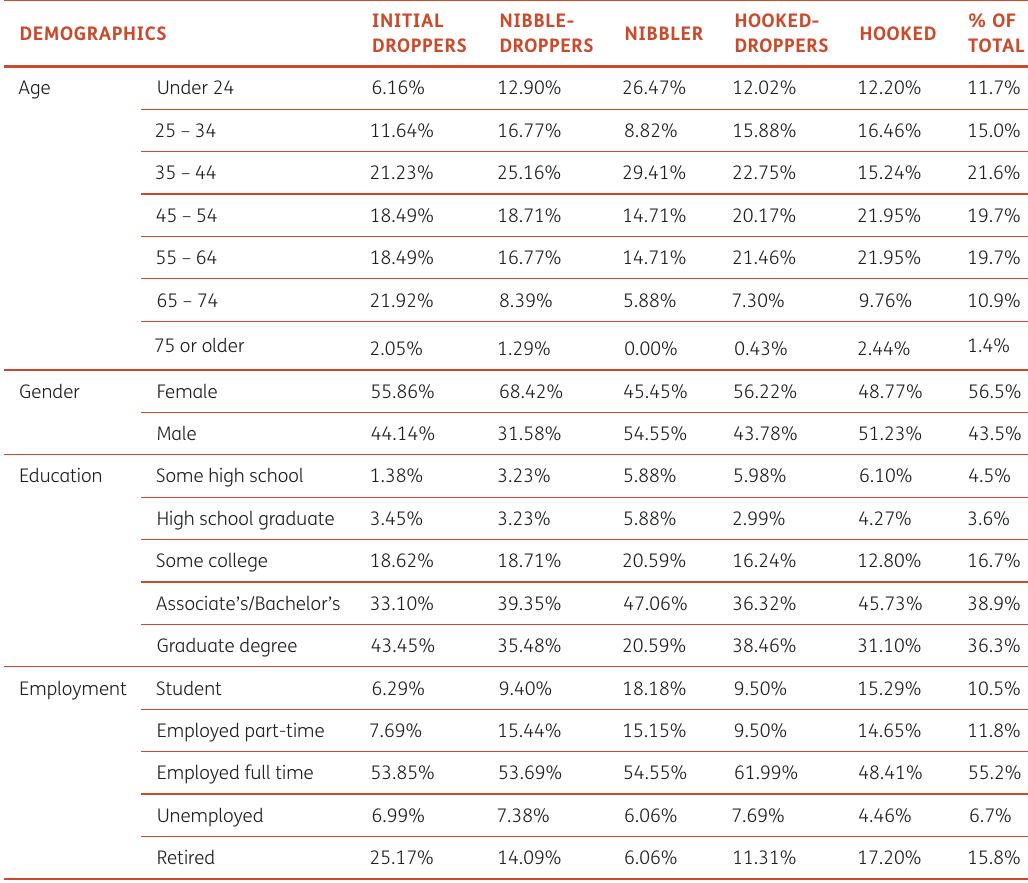
Table 2 Demographics of survey respondents. Percentages shown represent the percentages of individuals who are in a particular demographic, per total number of individuals in each category of participation, excepting the % of total column. Sample sizes are slightly smaller for Gender and Employment because some participants chose not to report responses to those categories.